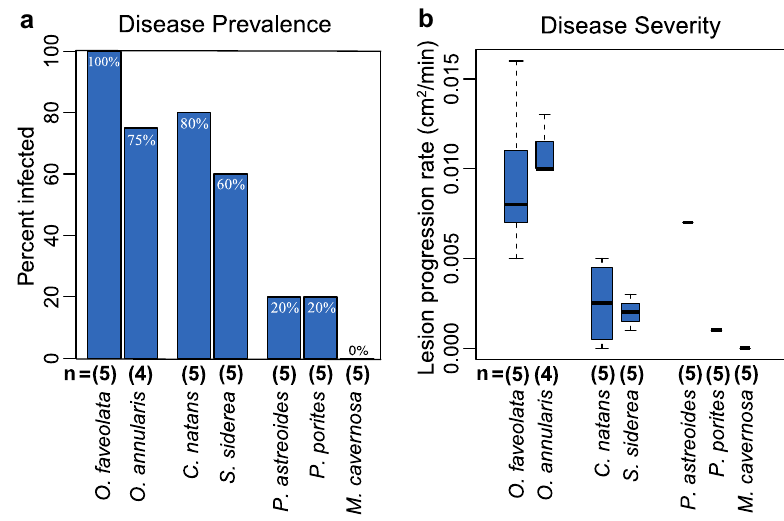
Fig. 2 Disease prevalence and severity. a Disease prevalence (percentage of replicates that contracted the disease) for each species. b Disease severity (the rate at which the disease lesion progressed across the infected coral after contracting white plague disease); only the corals that contracted the disease had their lesion progression rates graphed.